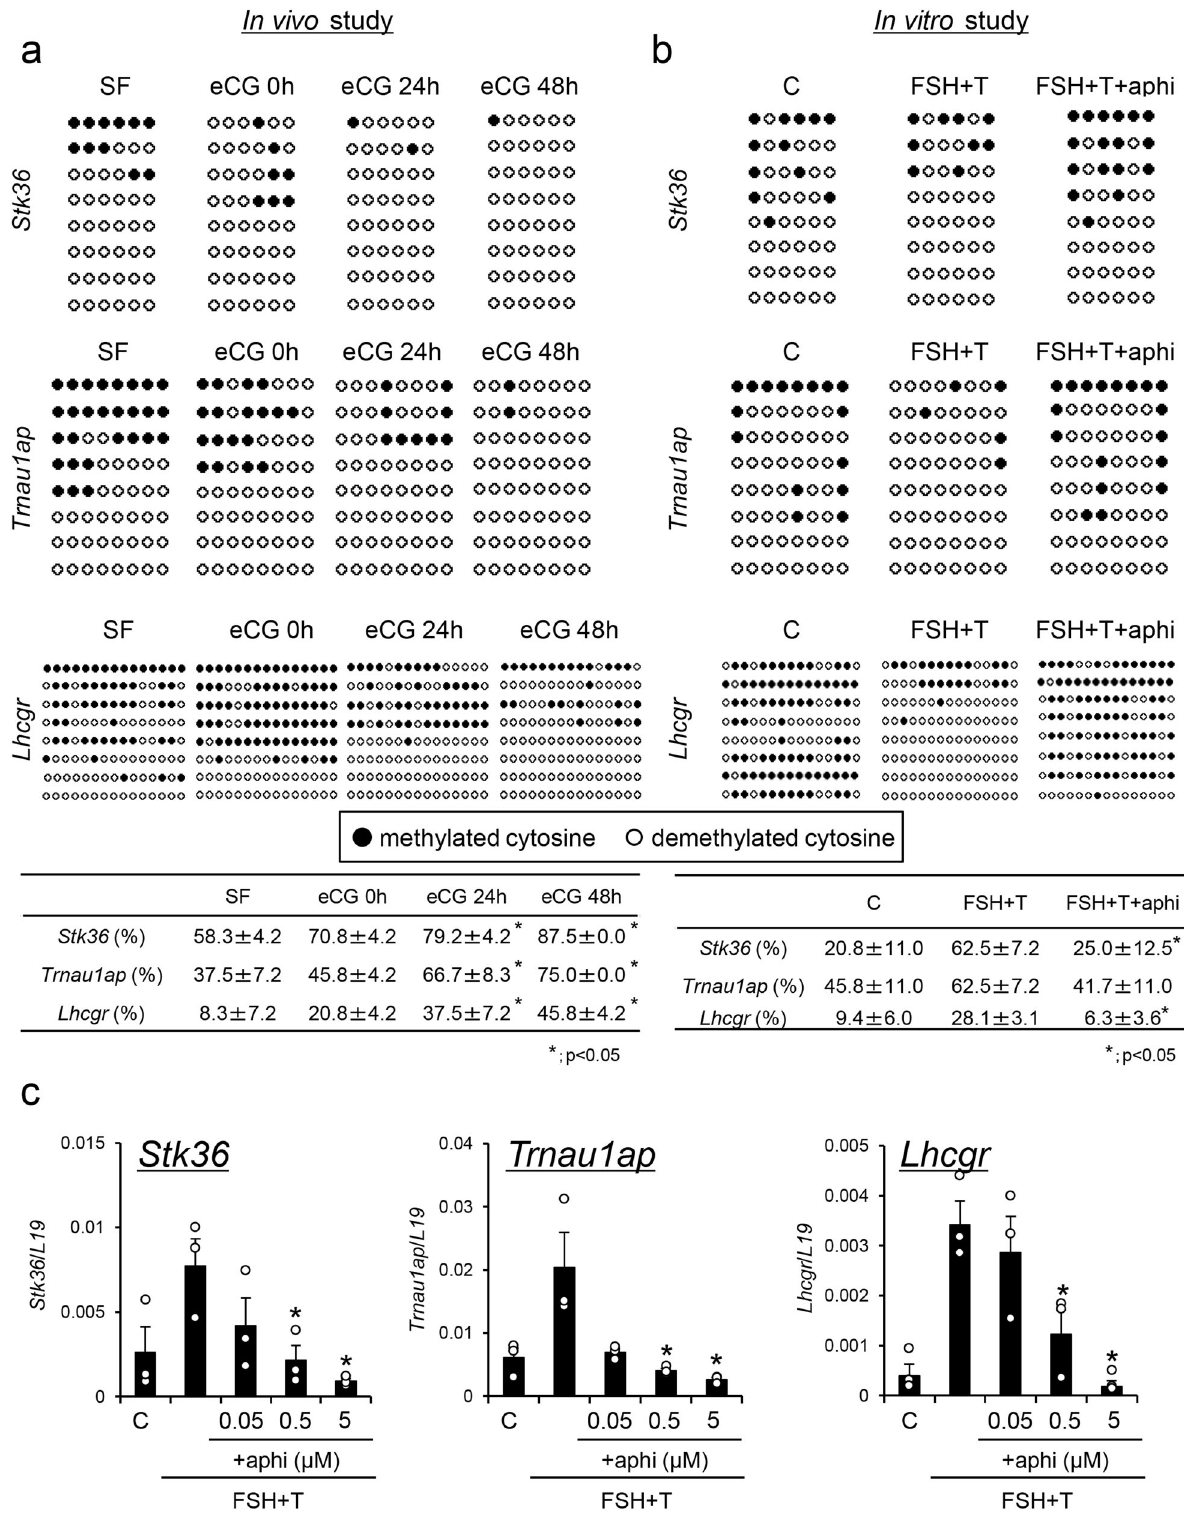
structural variations are regulated by the differences in DNA methylation and histone modi fi cations 34 that are controlled by hormones and signaling pathways that impact cell proliferation and differentiation 20,35 . In this study, we document that hormone-regulated proliferation and differentiation of granulosa cells during follicular development from the secondary to